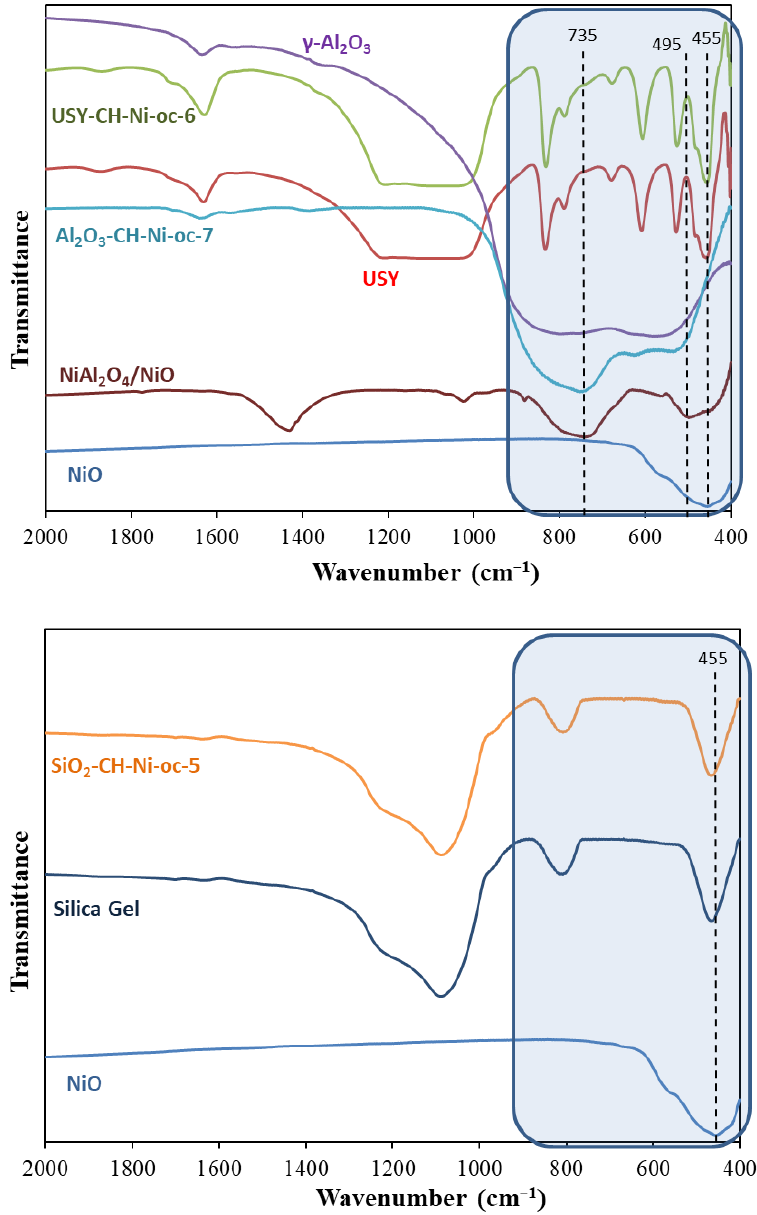
Figure 10. FTIR spectra of representative Ni-impregnated materials: SiO 2 -CH-Ni-oc-5 (1.5 wt.% Ni), Al 2 O 3 -CH-Ni-oc-7 (10 wt.% Ni), and USY-CH-Ni-oc-6 (2 wt.% Ni). The spectra of bulk NiO, NiAl 2 O 4 /NiO, silica gel, γ -Al 2 O 3 and USY zeolite, are also included for comparison.